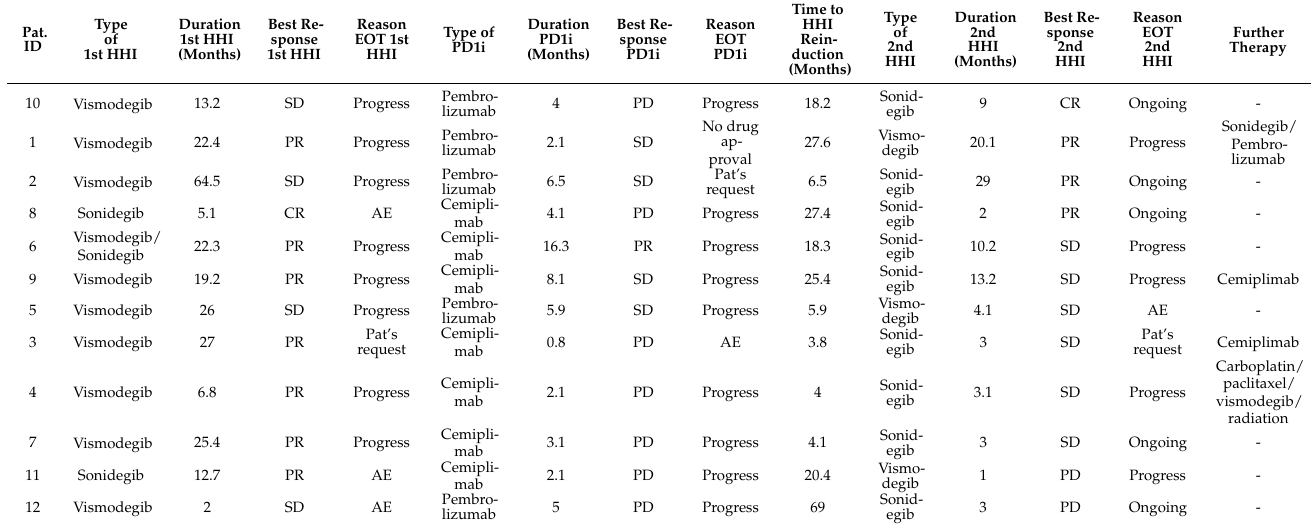
Table 2. Course of treatment per patient, hierarchically ordered according to best response to (i) HHI reinduction, (ii) PD1i and (iii) primary HHI